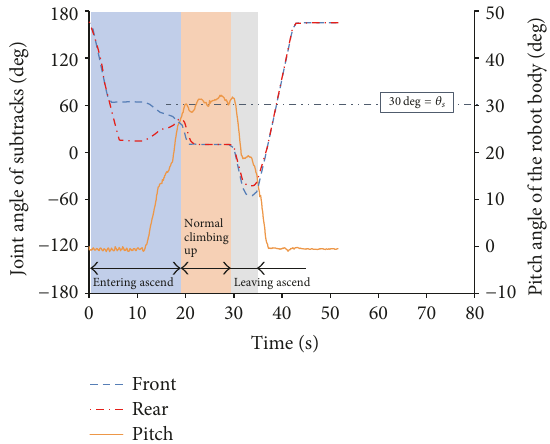
Figure 24: Data profile for 𝜃 𝑓 , 𝜃 𝑟 , 𝜃 𝑝 ( 𝜃 𝑠 = 30 ∘ , 𝑝 = 200 mm, ascend).